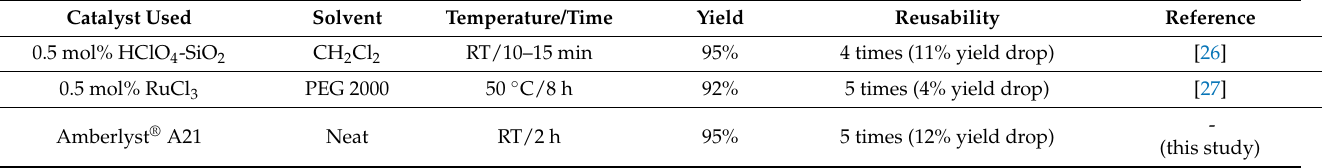
Table 2. Comparison of A21 catalyst and other reported catalysts in the synthesis of product 3a